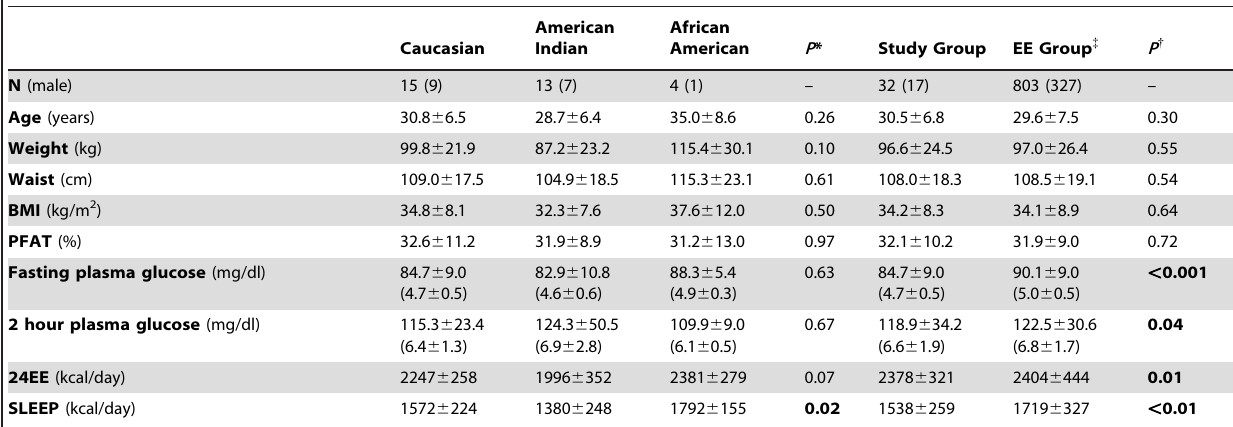
Table 2. Group characteristics.